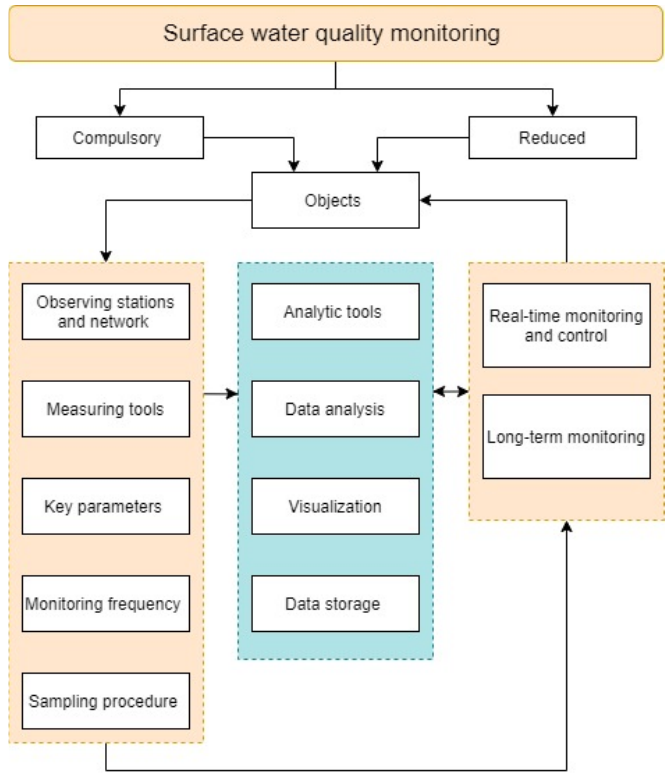
Figure 1. The base components of designing IoT-based systems for surface water monitoring The two basic issues, namely, (1) system design and (2) tools for data processing